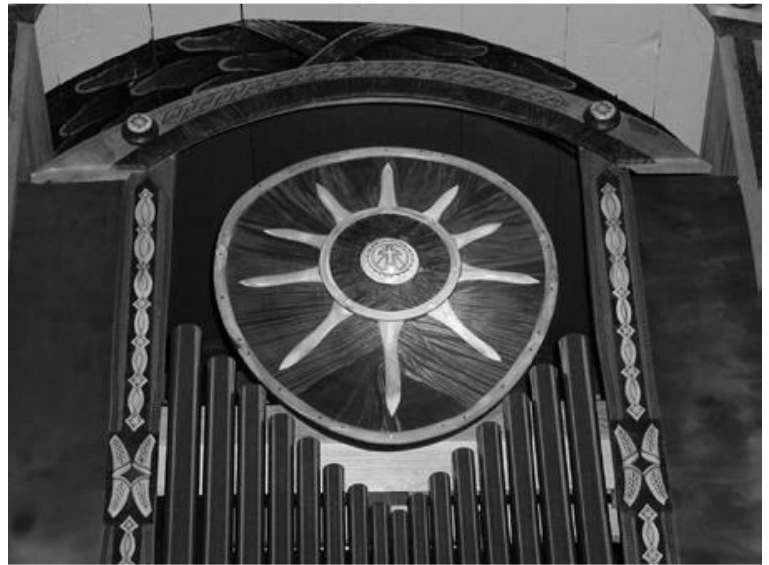
Figure 6. Altar in a Lutheran (Laestadian) church of Jukkasjärvi with pre-Christian symbols (the sun from a shamanic drum) made by Lars Levi Sunna (photo: Tamás 2018, p. 38).